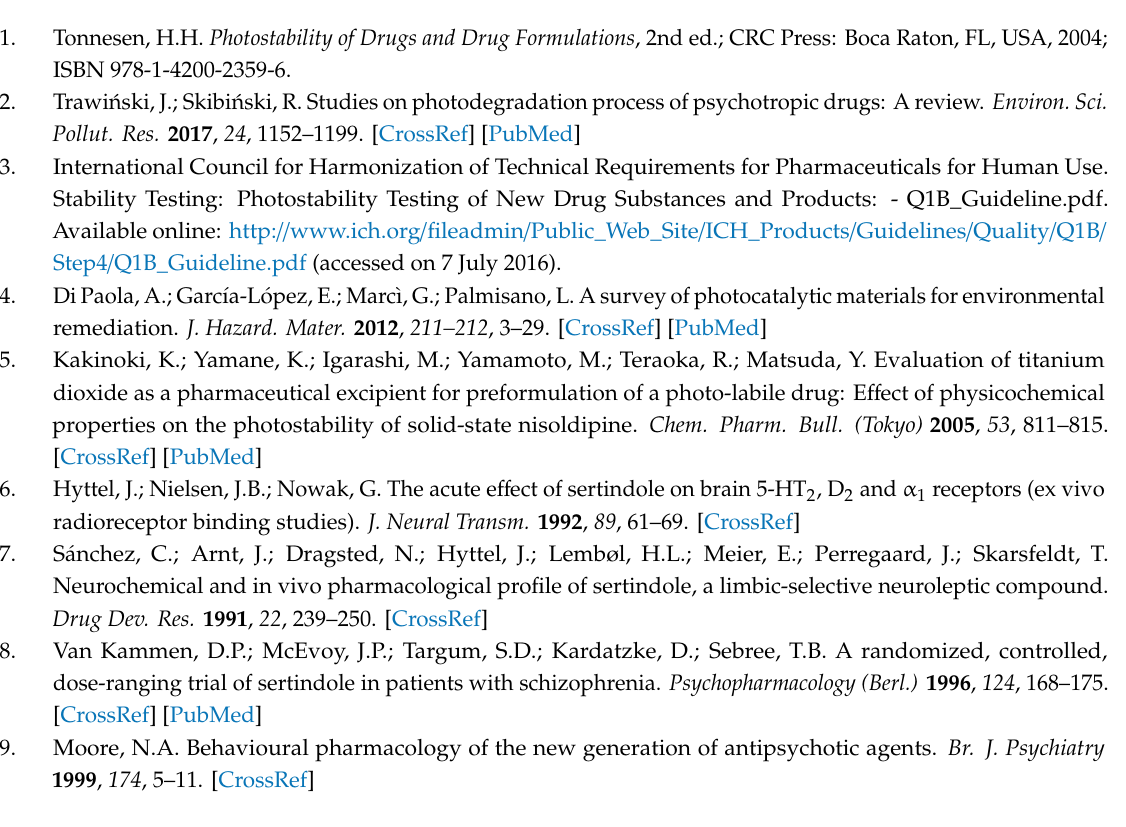
pattern of TP1, Figure S3: MS / MS spectrum and fragmentation pattern of TP2, Figure S4: MS / MS spectrum and fragmentation pattern of TP3, Figure S5: MS / MS spectrum and fragmentation pattern of TP4, Figure S6: MS / MS spectrum and fragmentation pattern of TP5, Figure S7: MS / MS spectrum and fragmentation pattern of TP6, Figure S8: MS / MS spectrum and fragmentation pattern of TP7, Figure S9: MS / MS spectrum and fragmentation pattern of TP8, Figure S10: MS / MS spectrum and fragmentation pattern of TP9, Figure S11: MS / MS spectrum and fragmentation pattern of TP10, Figure S12: MS / MS spectrum and fragmentation pattern of TP11, Figure S13: MS / MS spectrum and fragmentation pattern of TP12, Figure S14: MS / MS spectrum and fragmentation pattern of TP13, Figure S15: MS / MS spectrum and fragmentation pattern of TP14, Figure S16: MS / MS spectrum and fragmentation pattern of TP15, Figure S17: MS / MS spectrum and fragmentation pattern of TP16, Figure S18:, Figure S19: MS / MS spectrum and fragmentation pattern of TP18, Figure S20: Total ion chromatograms (overlay) of irradiated sertindole samples, Table S1: Calibration of the UHPLC method with DAD detection for determination of sertindole, Table S2: Robustness of the UHPLC method with DAD detection for determination of sertindole, Table S3: Toxicity of sertindole and its TPs to